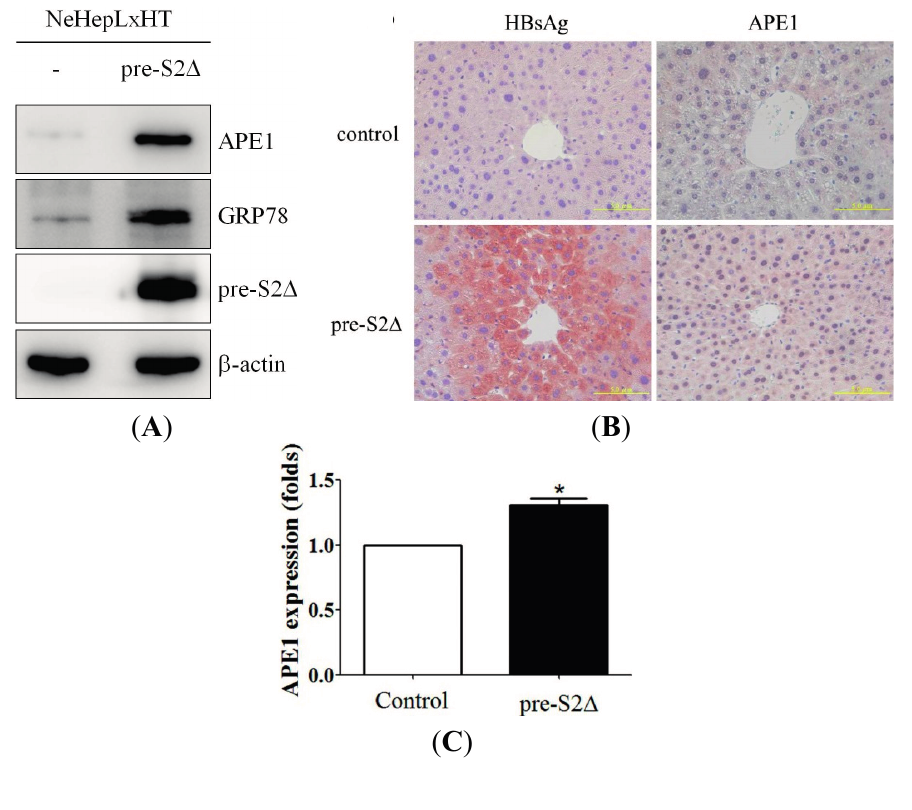
Figure 5. Induction of APE1 expression by HBV large surface mutant protein in vitro and in vivo . ( A ) APE1 expression was induced by ER stress-associated protein, pre-S2 Δ , in vitro . The NeHepLxHT cells and NeHepLxHT-pre-S2 Δ cells were cultured in 10% FBS-supplemented DMEM. The total cell lysates were analyzed by Western blotting with antibodies for APE1, GRP78, and β -actin; ( B ) Elevated APE1 is associated with pre-S2 ∆ expression in vivo . The expression of APE1 and HBV surface proteins in liver tissues of control and pre-S2 ∆ transgenic mice was analyzed by immunohistochemical staining (×400). Scale bar: 50 µm; and ( C ) The expression levels of APE1 were quantified by using ImageJ software. The data represent the mean of APE1 protein expression level from three independent experiments. Columns, mean of three independent experiments; bars, SD ( * , p < 0.05, Student’s t